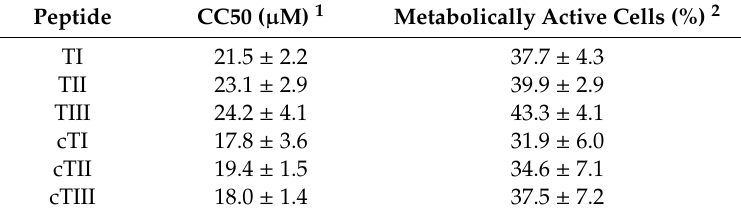
Table 4. Activity of tachyplesin I–III (TI–TIII) and cyclic analogues (cTI–cTIII) against S. aureus ATCC 6538 in the biofilm growth form.